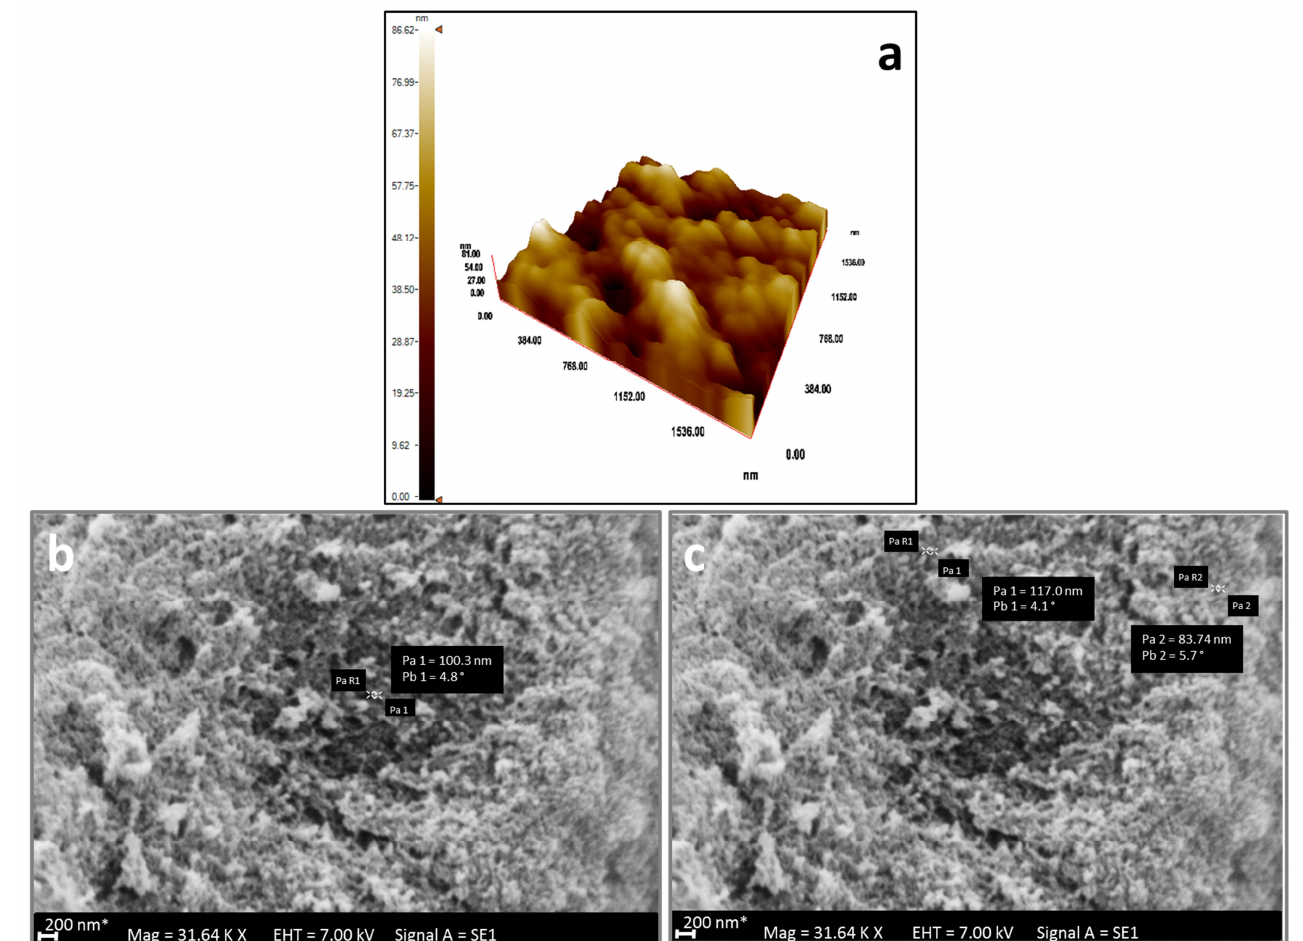
Figure 5. 3D AFM view of Cu(II)-MIP nanoparticles ( a ); SEM images of Cu(II)-MIP1 ( b ) and Cu(II)- MIP2 ( c )